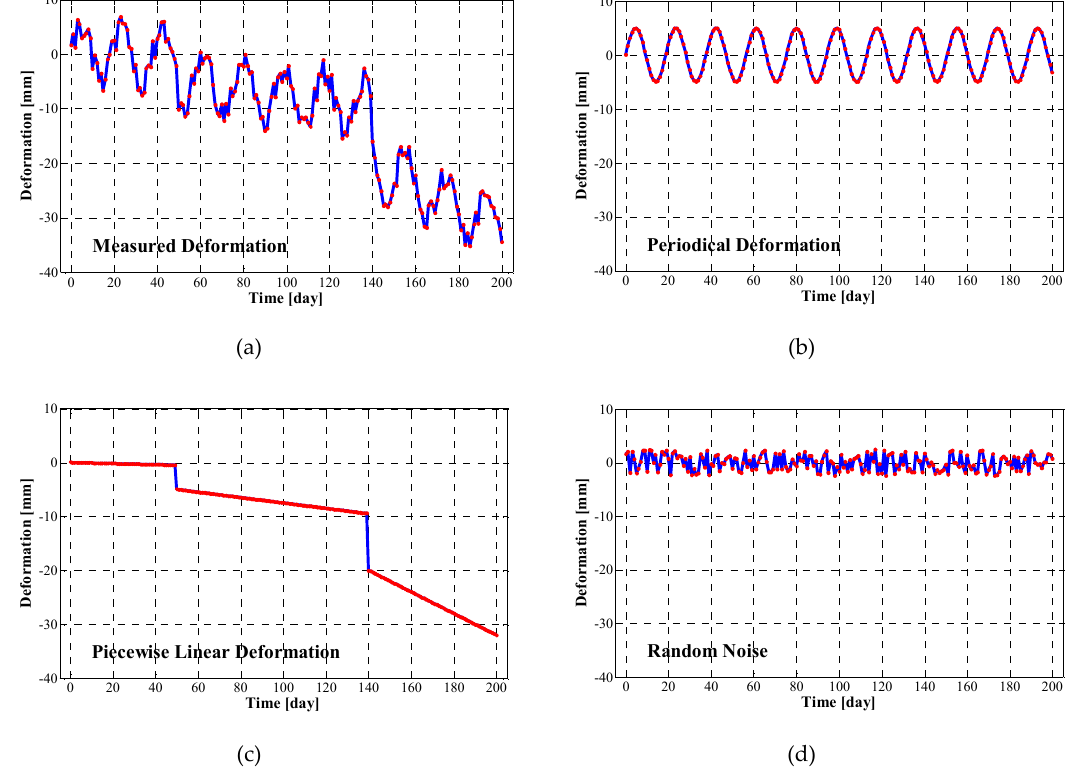
Figure 8. Example of temporal analysis on simulated data: Original measured deformation ( a ); retrieved periodic component ( b ), piecewise linear component ( c ), and random noise ( d